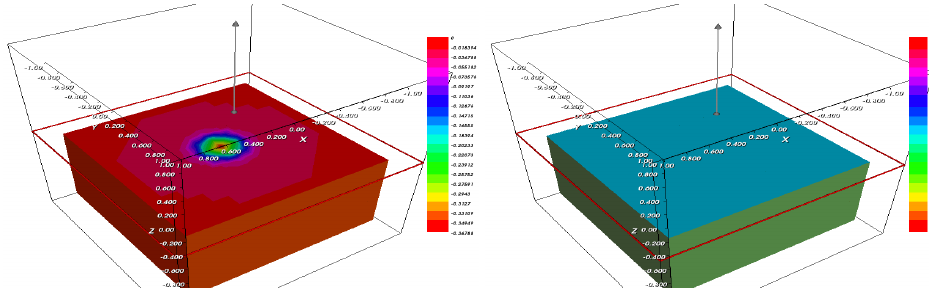
Figure 15. The fraction ϕ ( left ) and ψ ( right ) after T = 0.